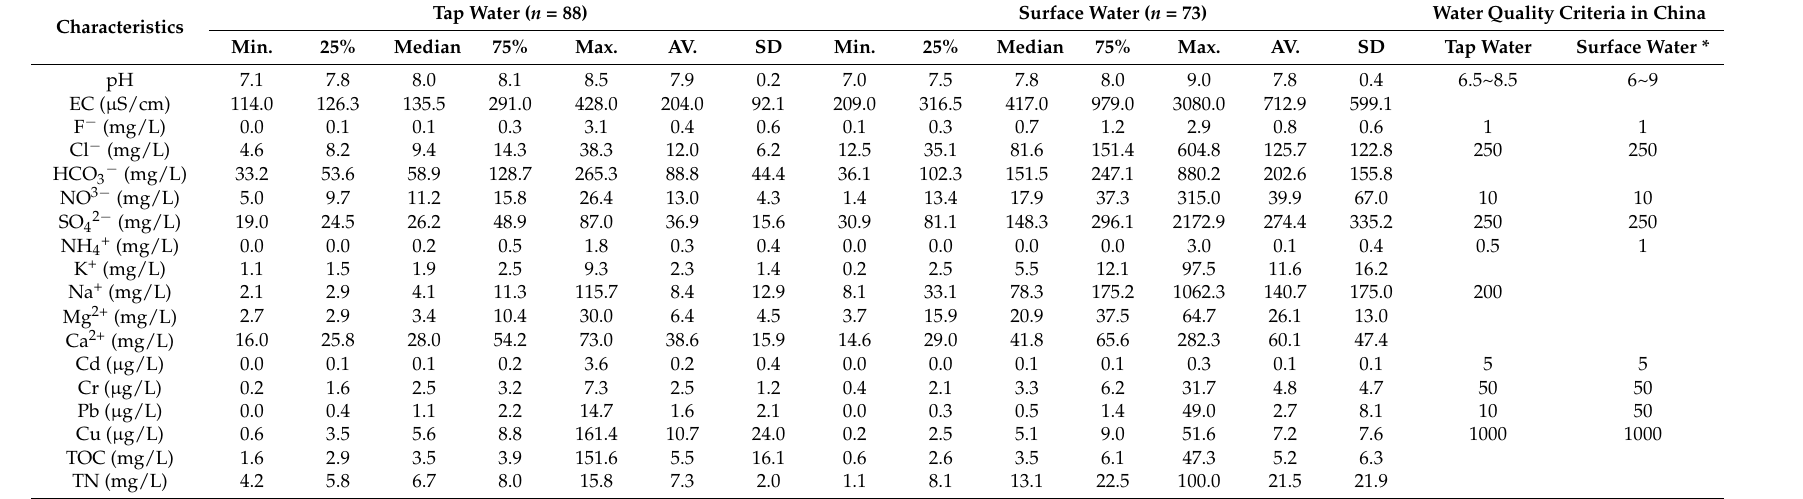
Table 4. An overview of MEs for DW and SW in the five major cities, NW, China.